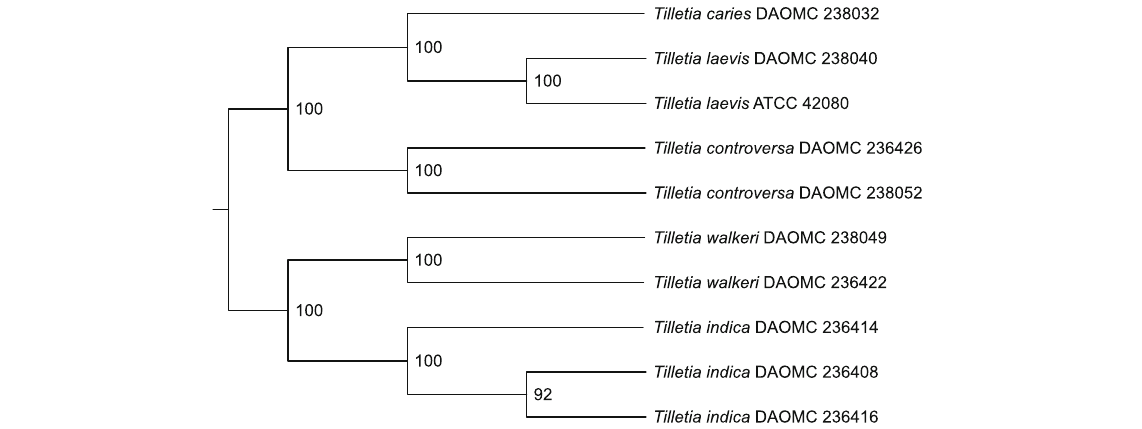
Fig. 3 ASTRAL greedy consensus cladogram based on analyses of individual bootstrap trees of the 4896 single copy orthologous genes shared between the ten Tilletia strains. Support values show the percentage of bootstrap replicates that contain that branch